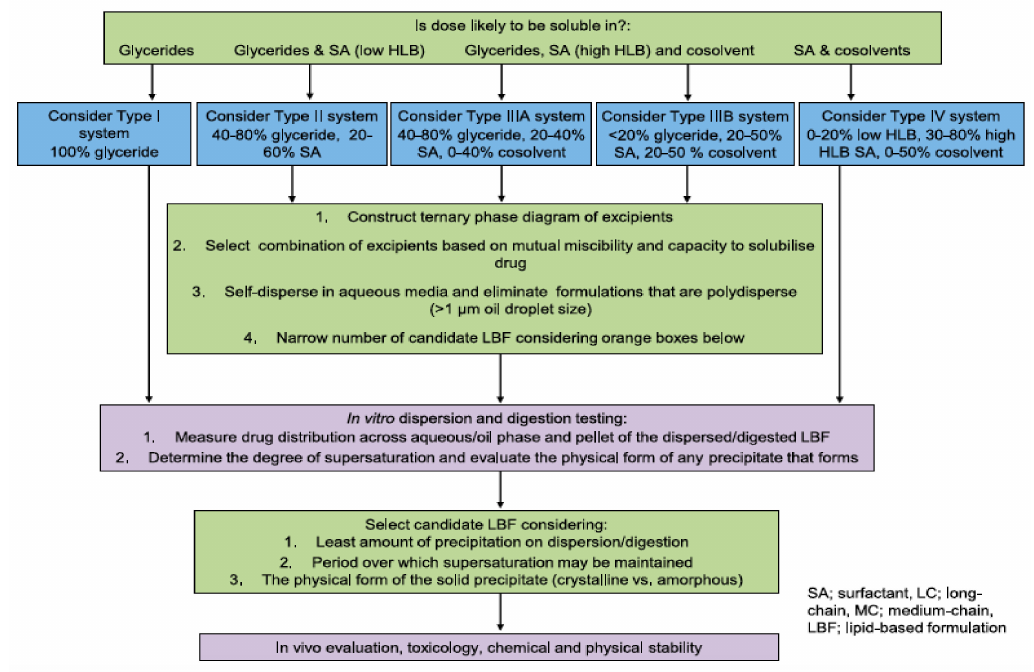
Figure 9. A flowchart providing a general guide to lipid-based formulation design. From